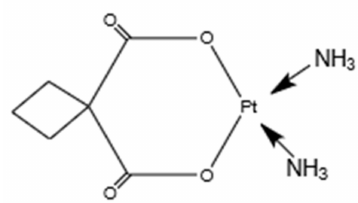
Figure 1. Molecular structure of carboplatin (C 6 H 12 N 2 O 4